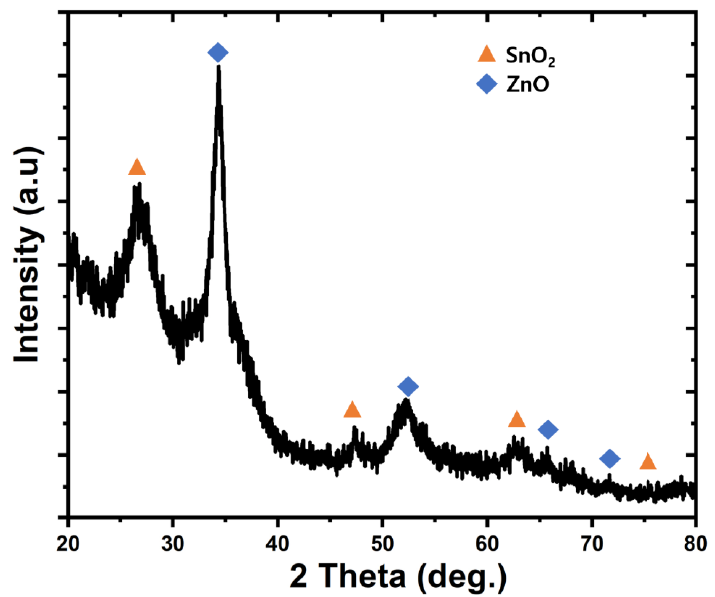
Figure 3. XRD patterns of SnO 2 /ZnO heterostructures.